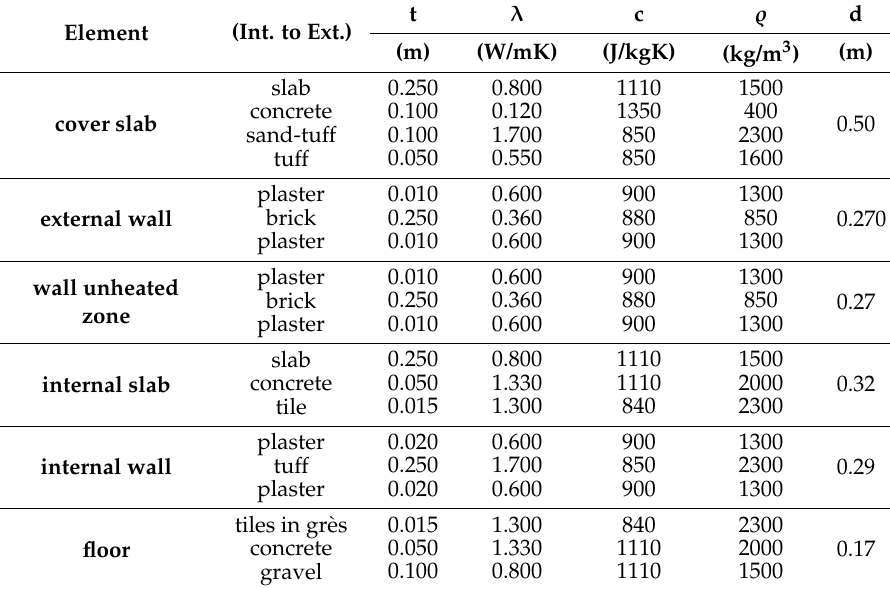
Table 1. Materials used in the existing building.